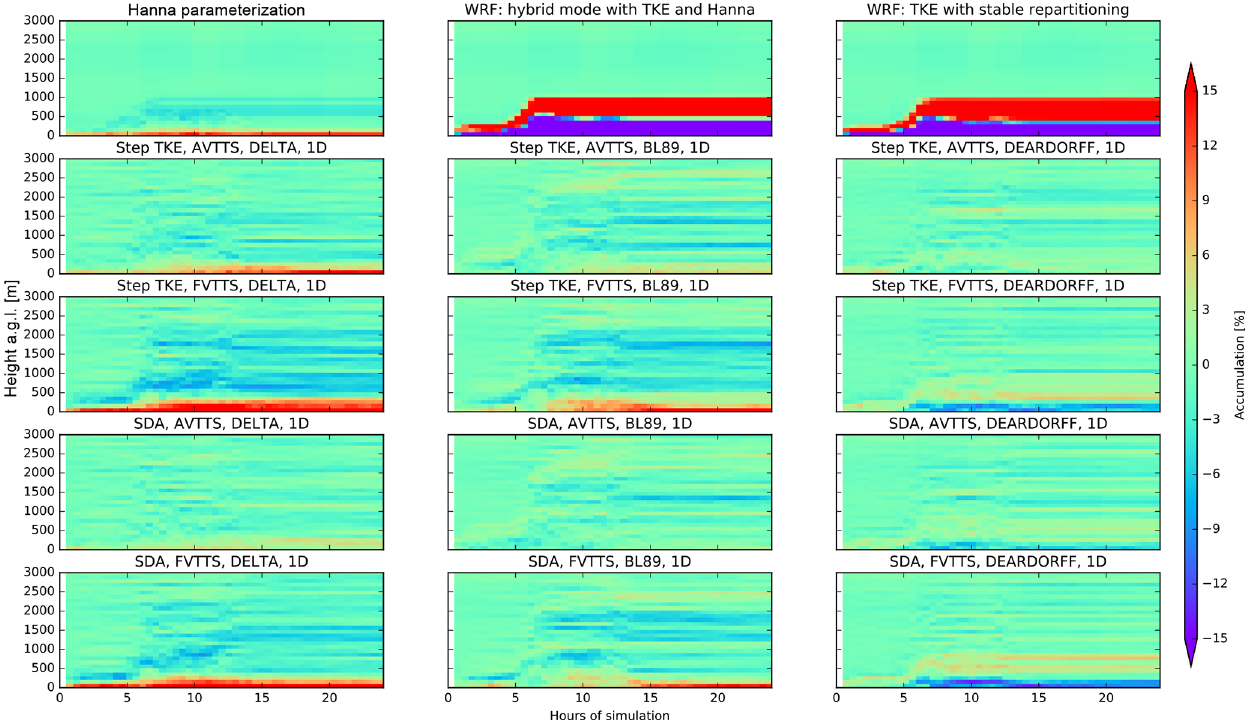
Figure C1. Accumulation in well-mixed test in all different turbulence configurations in FLEXPART-AROME. These tests were run in a column over the ocean